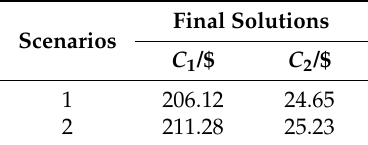
Table 8. Cost in two scenarios.